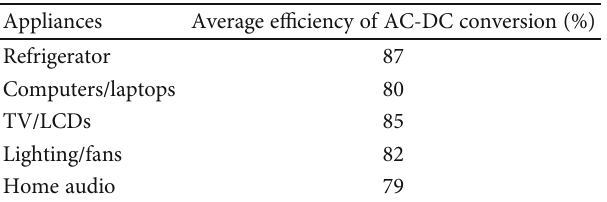
Table 3: The e ffi ciency of AC-DC conversion for AC loads